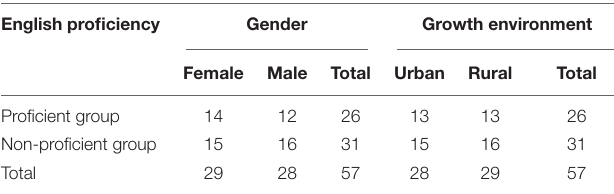
TABLE 1 | The number of participants on gender, growth environment and English proficiency in experiment